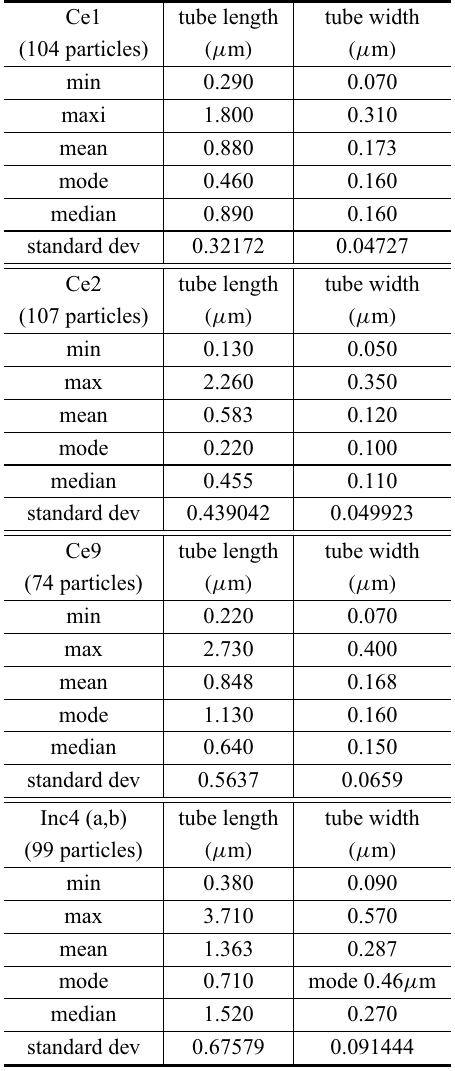
Measurements of the area, length and width of hal- loysite tube particles in SEM